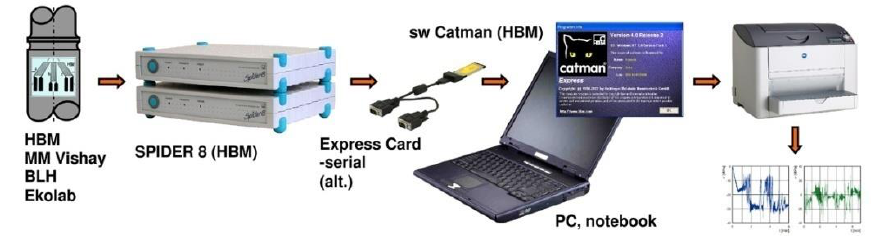
Figure 7. Configuration of the strain gauge measuring chain used for dynamic measurement.